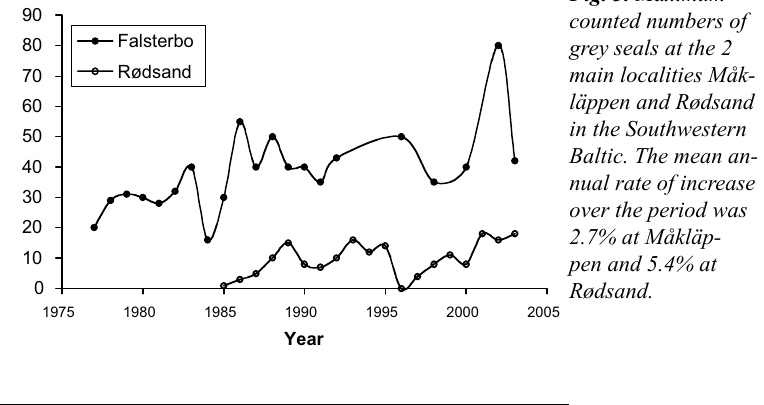
Fig. 3. Maximum counted numbers of grey seals at the 2 main localities Måk - läppen and Rødsand in the Southwestern Baltic. The mean an - nual rate of increase over the period was 2.7% at Måkläp - pen and 5.4% at